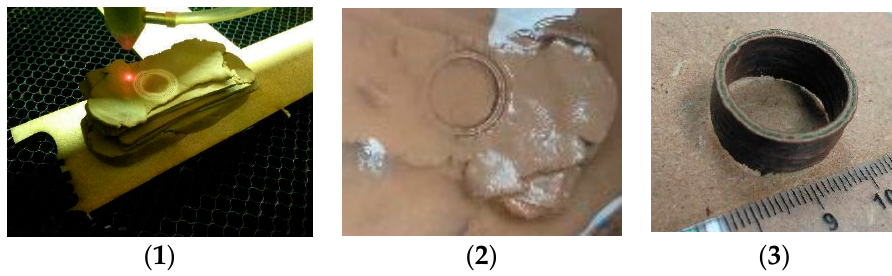
Figure 4. Laser 3D clay printing test, steps: ( 1 ) Laser used to process multiple levels of clay, ( 2 ) clay cleaned with water, ( 3 ) final sample.